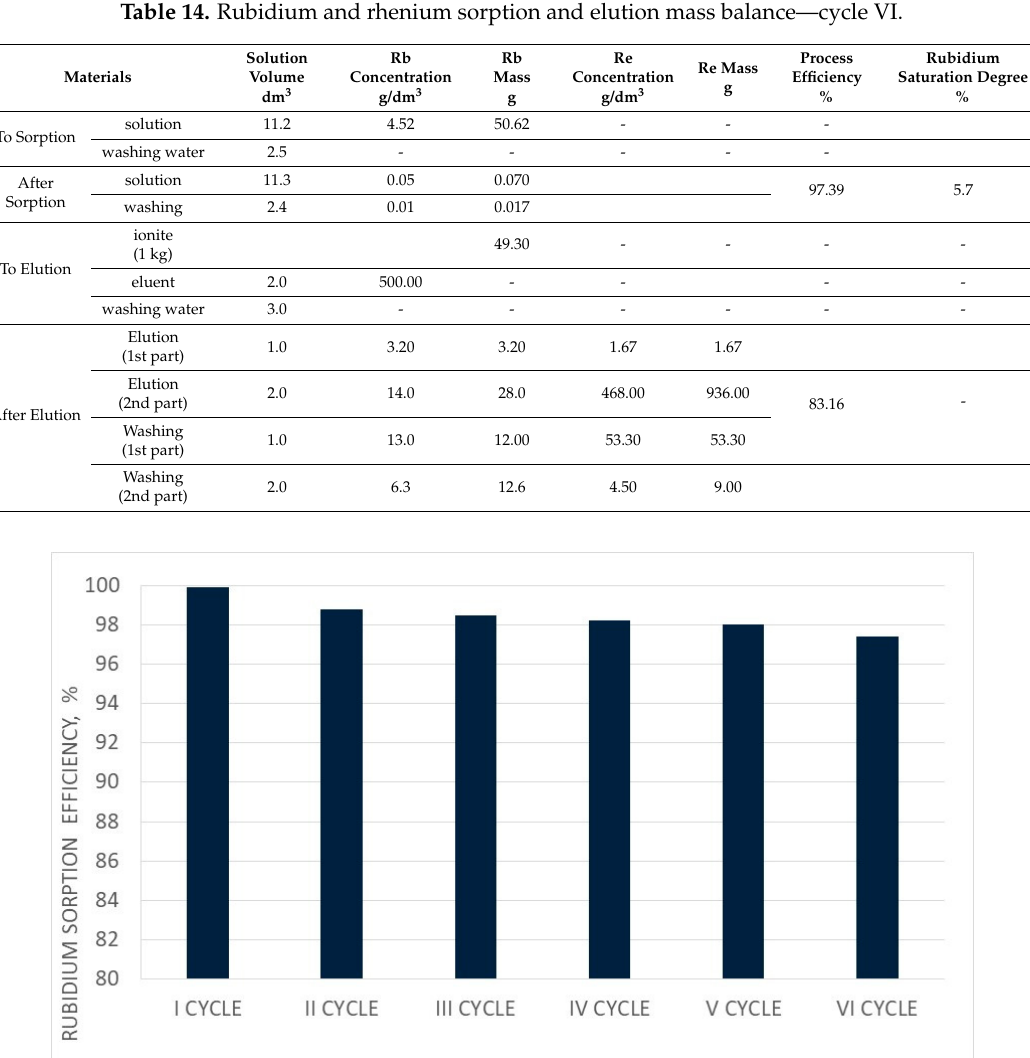
Figure 9. Changes in sorption efficiency in subsequent cycles (I–VI).